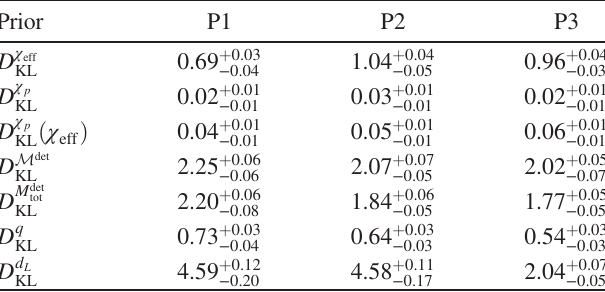
TABLE VI. KL divergences (in bits) between the prior and posterior distribution for various parameters for GW170809 under the three different prior assumptions P1, P2, and P3. We note that the values for P1 are different from the ones in Table V, as we consider only the IMRPhenomPv2 model